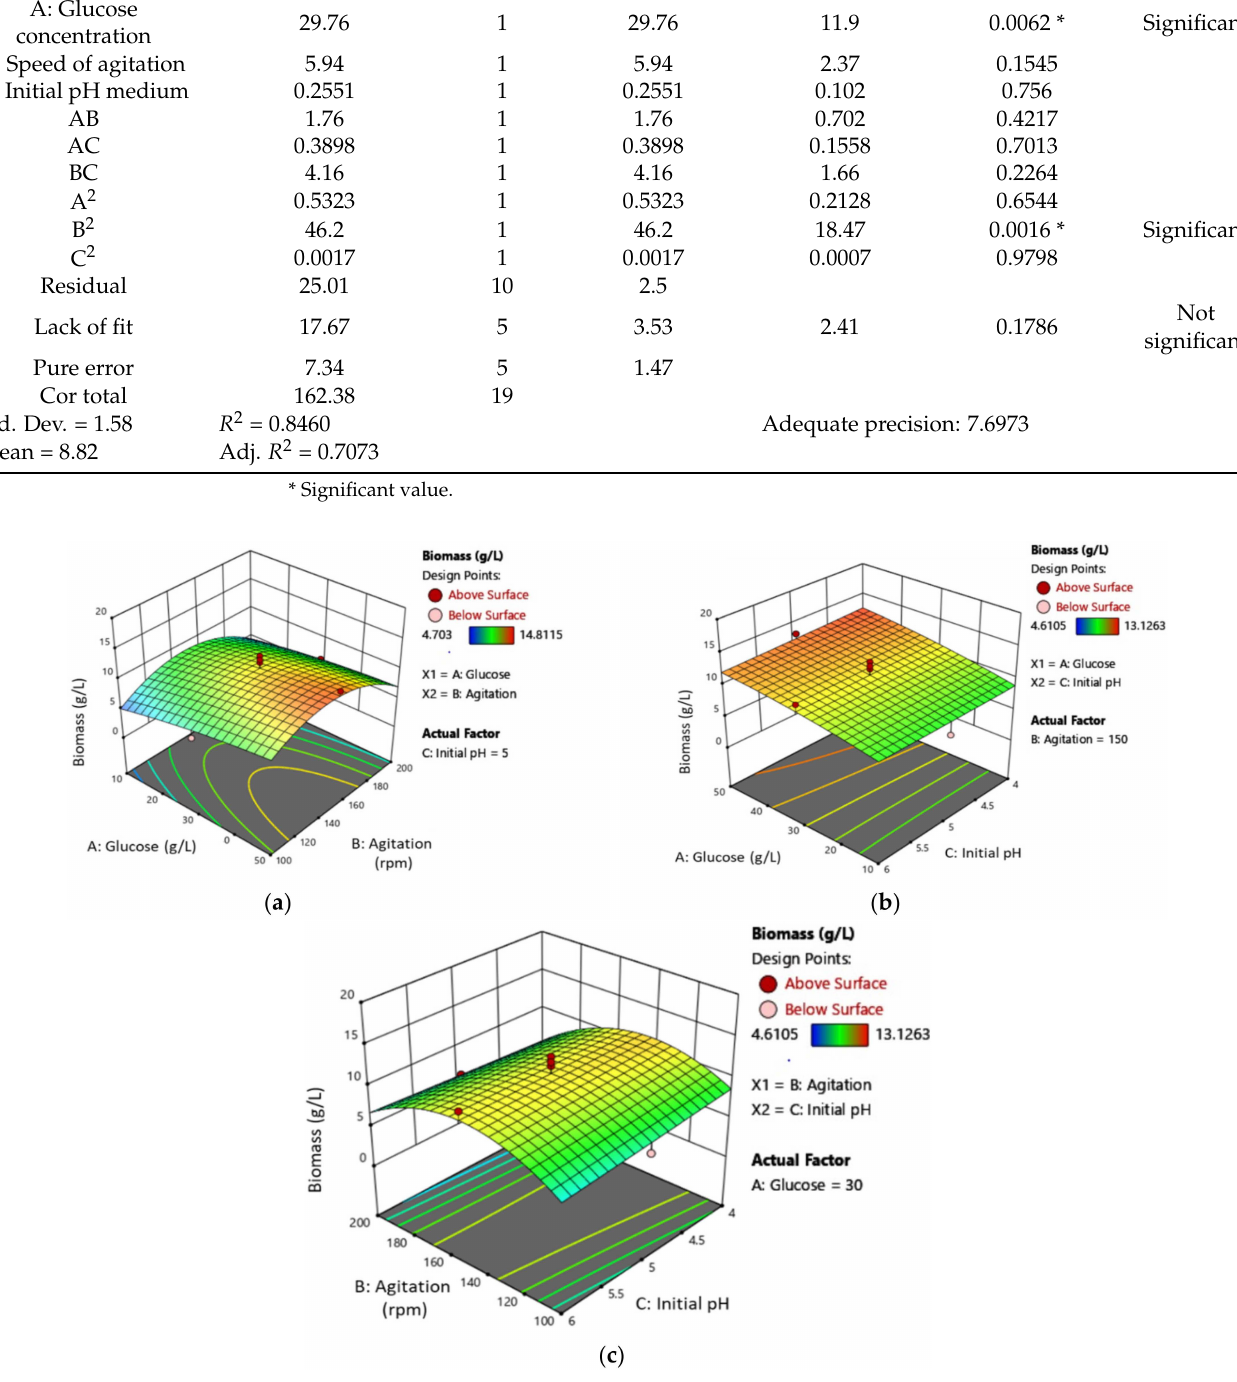
Figure 3. Three-dimensional (3D) response surface plot of L. rhinocerus’ MB showing the interaction between ( a ) glucose concentration and the speed of agitation, ( b ) glucose concentration and initial pH medium, and ( c ) speed of agitation and initial pH